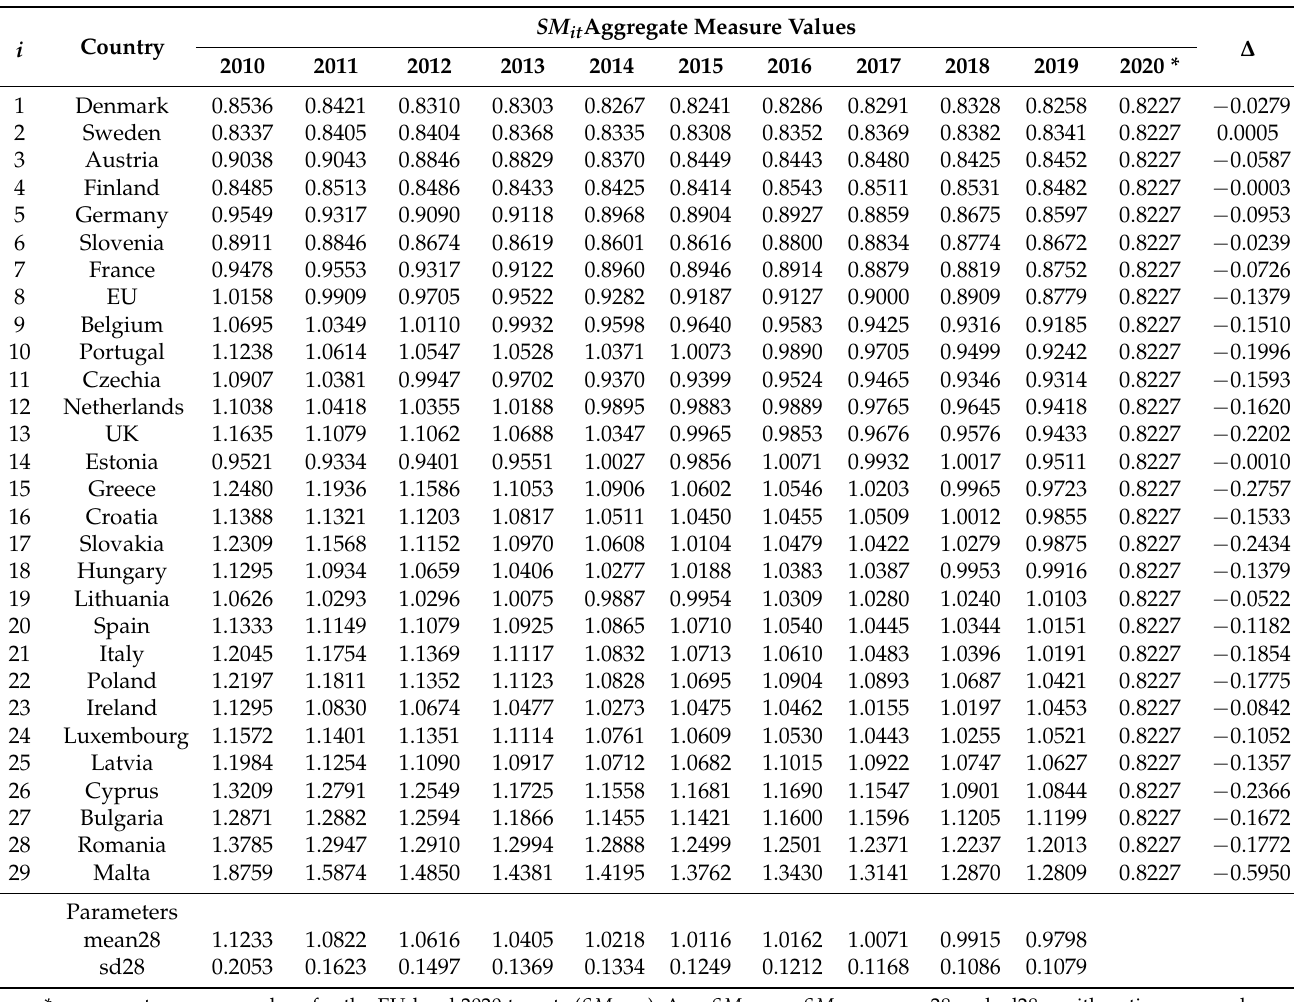
Table 4. SM it aggregate measure values for the EU-level target analysis, showing changes in the implementation of the EU Strategy from 2010 to 2019, and sorted by 2019